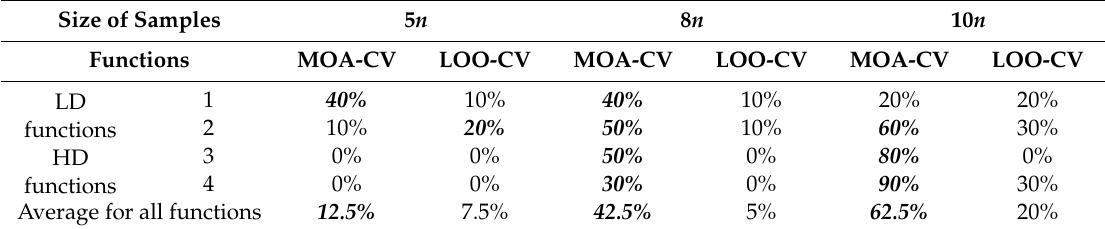
Table 6. Accurate rate of selecting best models.